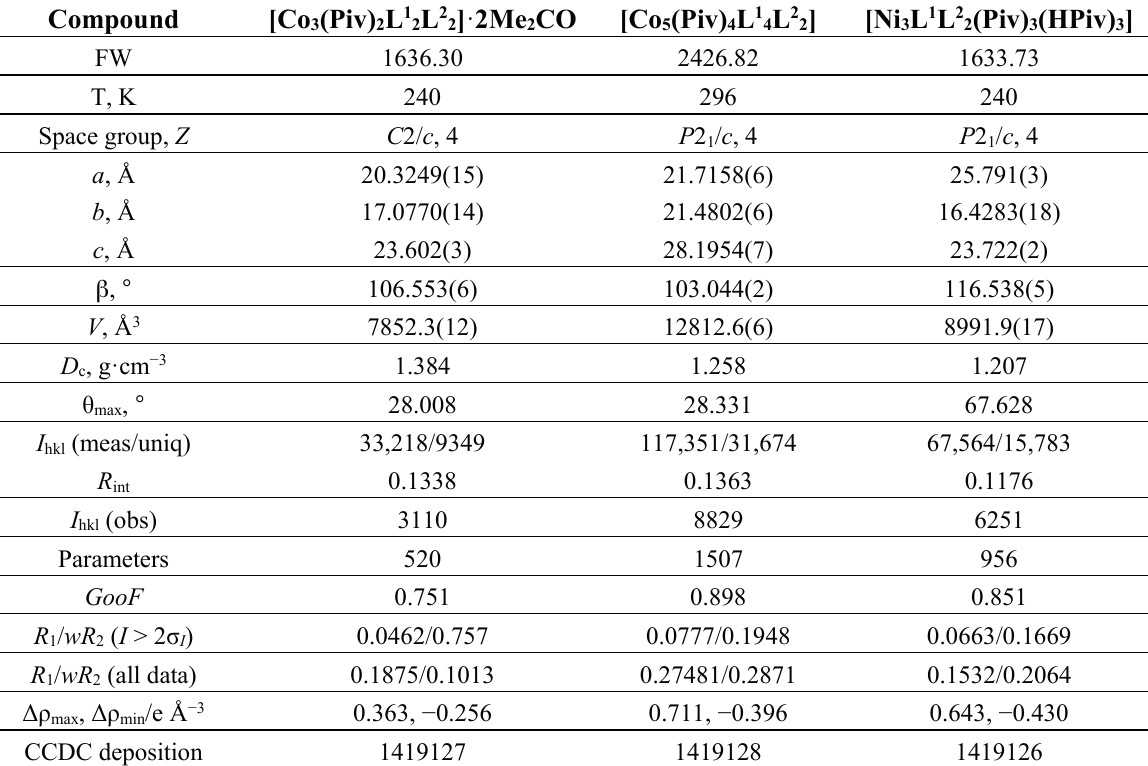
Table 1. Crystal data and the details of the experiments for the